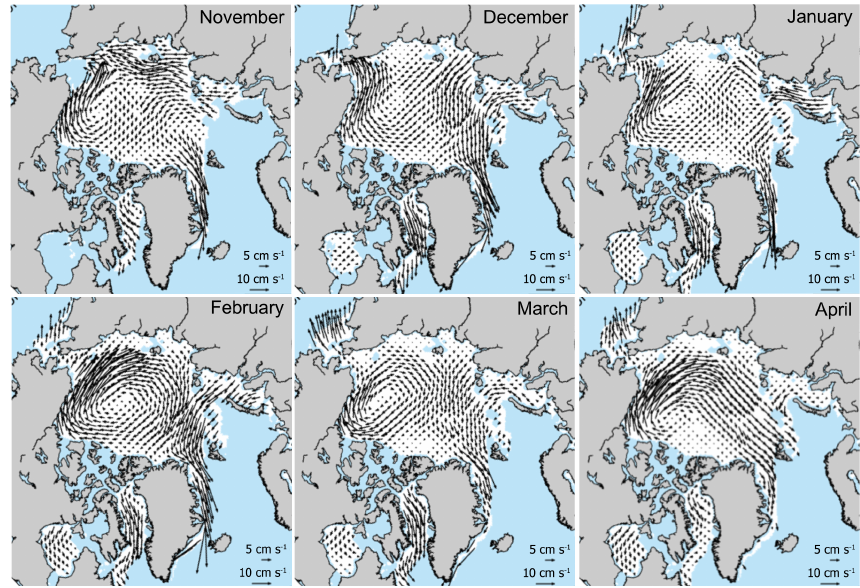
Figure 4. NSIDC November 2015 to April 2016 monthly mean sea ice drift vectors. Adapted from images retrieved from https://daacdata. apps.nsidc.org/pub/DATASETS/nsidc0116_icemotion_vectors_v3/browse/north/ (last access: 23 February 2018).